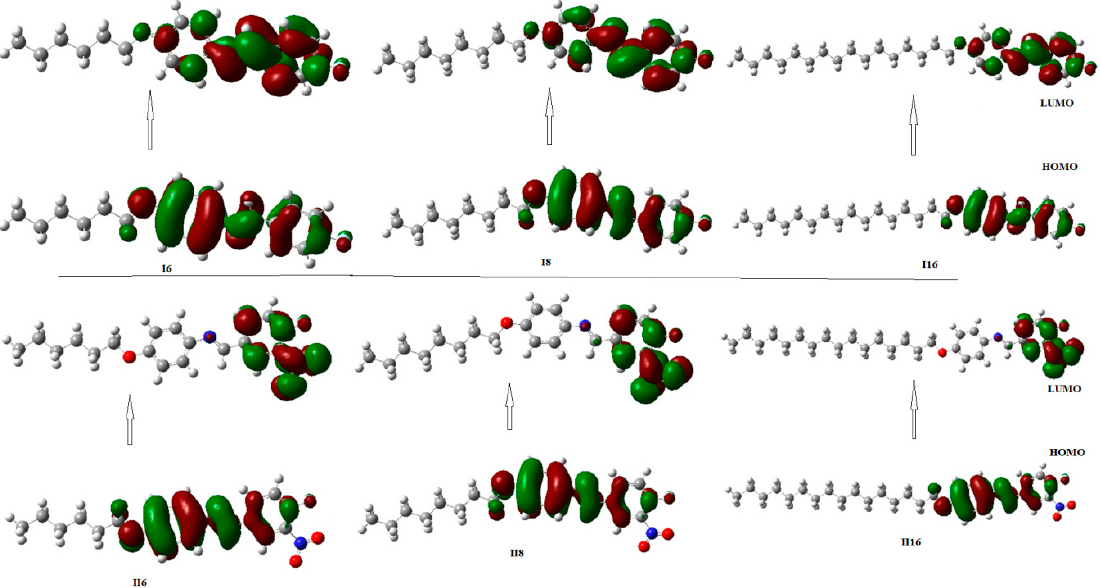
Figure 5. Estimated geometry for frontier molecular orbitals (FMOs) of the investigated groups, I n and II n.